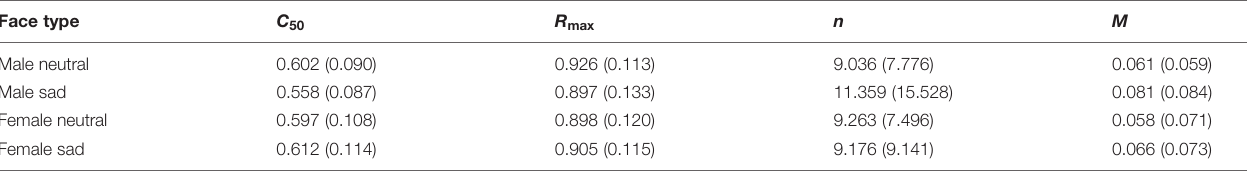
TABLE 2 | Mean and SD of psychometric curve fit